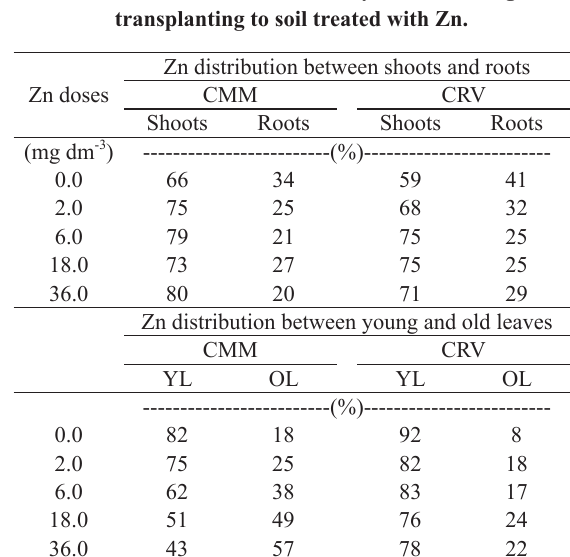
919 CADMIUM AND ZINC TRANSFERENCE FROM SOIL TO LETTUCE PLANTS